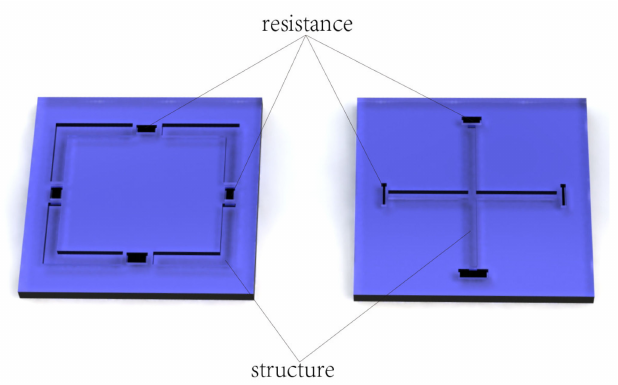
Figure 1. Etching a groove on the film structure to improve sensitivity might lead to instability in a harsh